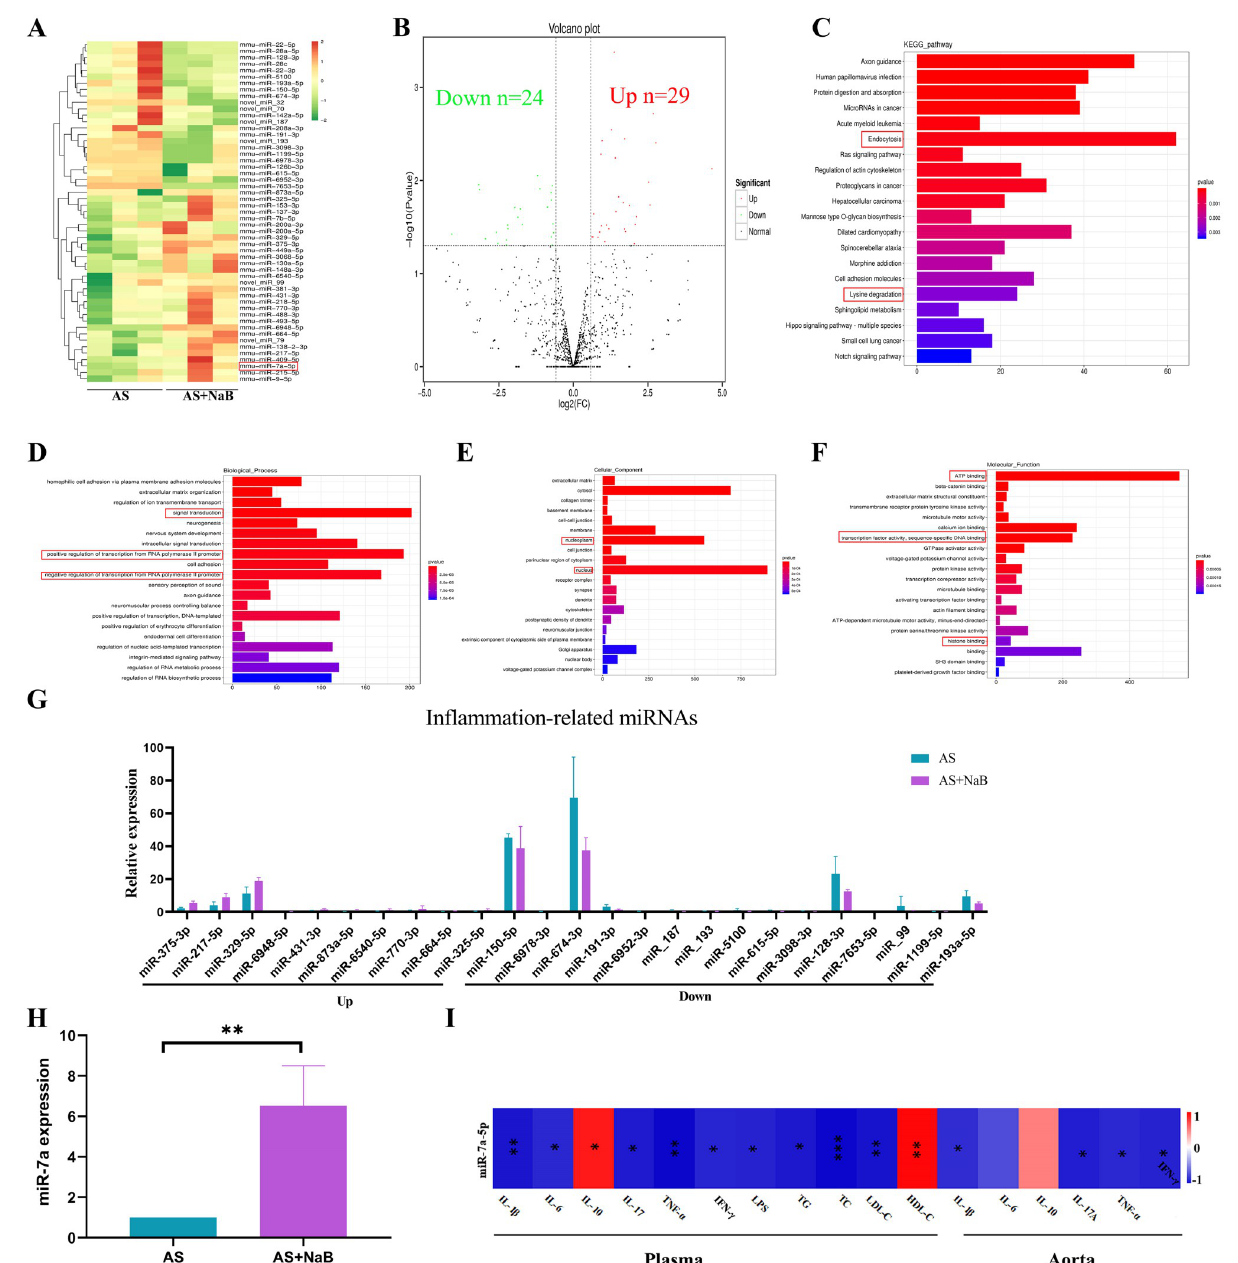
Fig 8. NaB altered the aorta transcriptome. (A) MiRNAs cluster heatmap with differential expression in AS and AS+NaB groups. (B) Differential- expression volcano diagram. (C) KEGG enrichment plot of differential miRNA host genes between AS and AS+NaB. (D-F) GO analysis of miRNA host genes between AS and AS+NaB. (G) Inflammation-related miRNAs. (H) The expression level of miR7a-5p was measured by real-time PCR. (I) Correlation analyses between the relative abundance of miR7a-5p and other related indicators. � P < 0.05, �� P < 0.01, ��� P < 0.001. ns, no significant